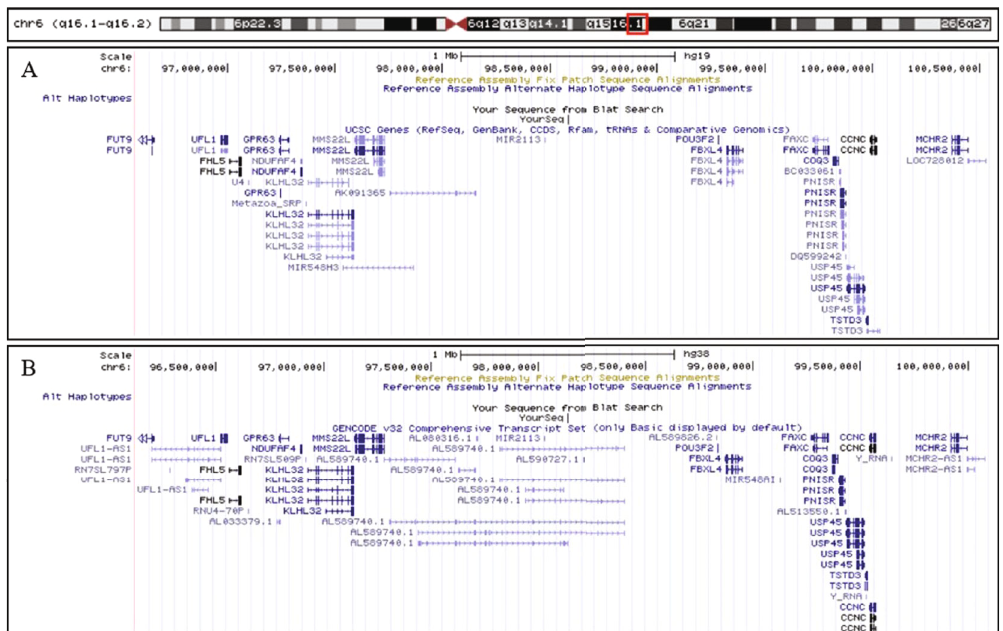
Figure 2: Region of polymorphism rs9320913 (Chr6: 98136857) searched on hg19 (a) and hg38 (b) genome browser